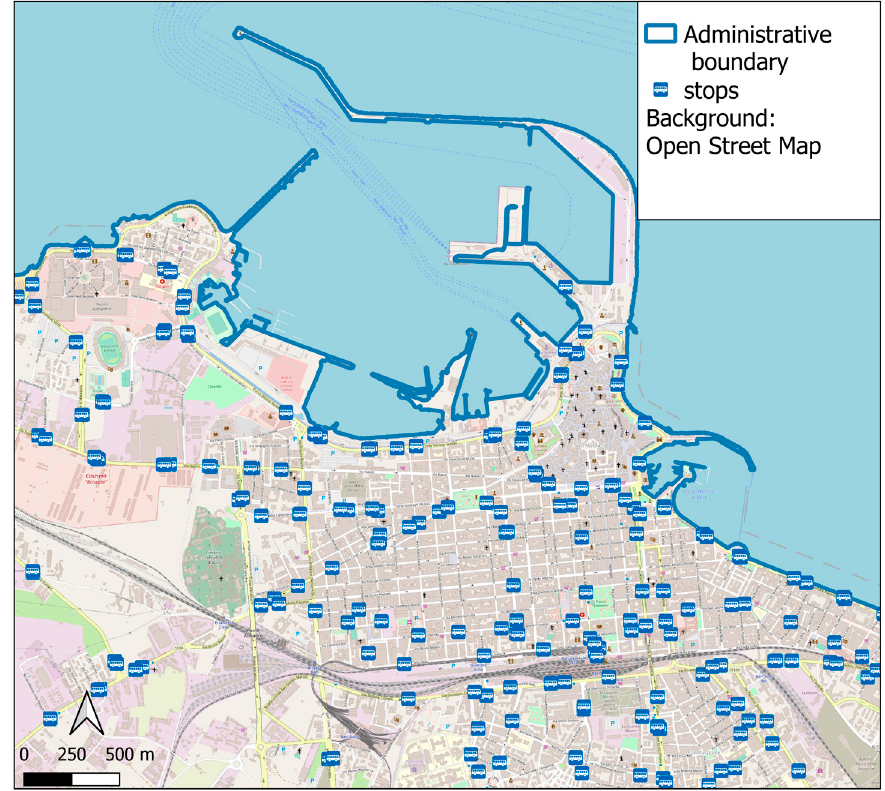
Figure 8. Close-up of Bari bus stop map from Bari municipality open-data portal.